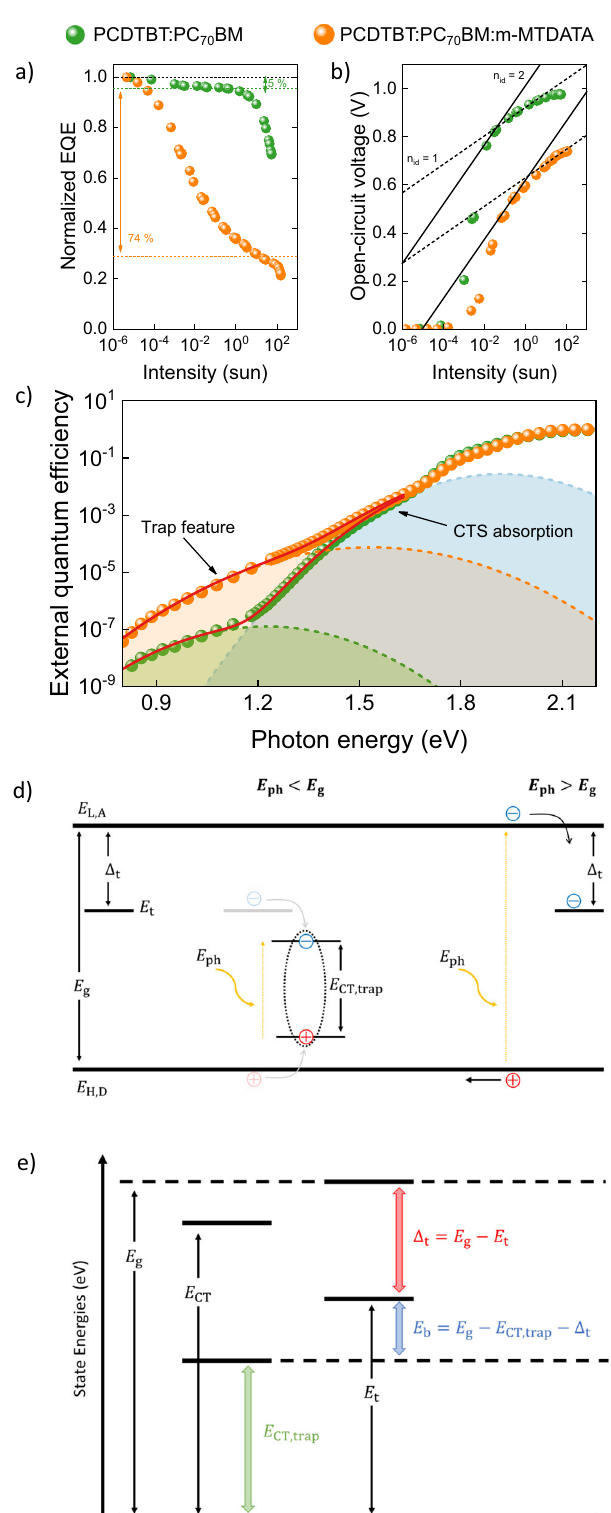
Fig. 3 Trap states in organic solar cells probed by combined IPC, V oc , and ultra-sensitive EQE measurements. a Normalized light intensity- dependent EQE of a PCDTBT:PC 70 BM solar cell, and compared to a PCDTBT:PC 70 BM:m-MTDATA (1%) device. b Open-circuit voltage ( V oc ) of a PCDTBT:PC 70 BM and PCDTBT:PC 70 BM:m-MTDATA solar cells shown as a function of intensity. Dotted and solid lines are guides to the eye corresponding to ideality factors of n id ¼ 1 and n id ¼ 2 respectively. c